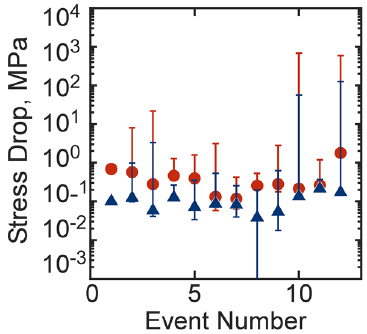
Fig. 9 Stress drops within an earthquake cluster after event selection. Red circles indicate the results obtained from large earthquakes, and blue triangles indicate results obtained from smaller earthquakes. The original figure before the event selection is Fig.